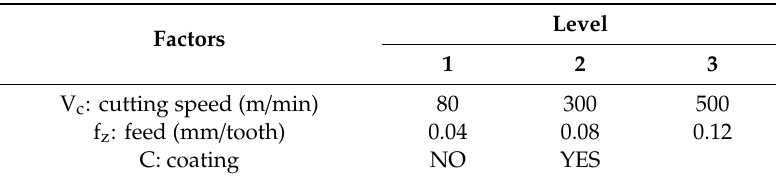
Figure 2. Research plan. CFRP: Carbon fibre reinforced polymer. Table 1. Design of experiment.